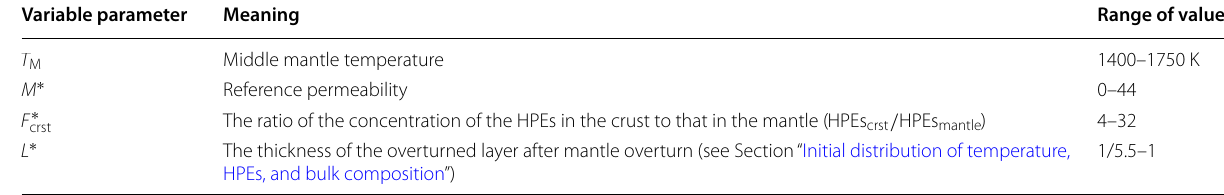
The parameters indicated by asterisks are dimensionless